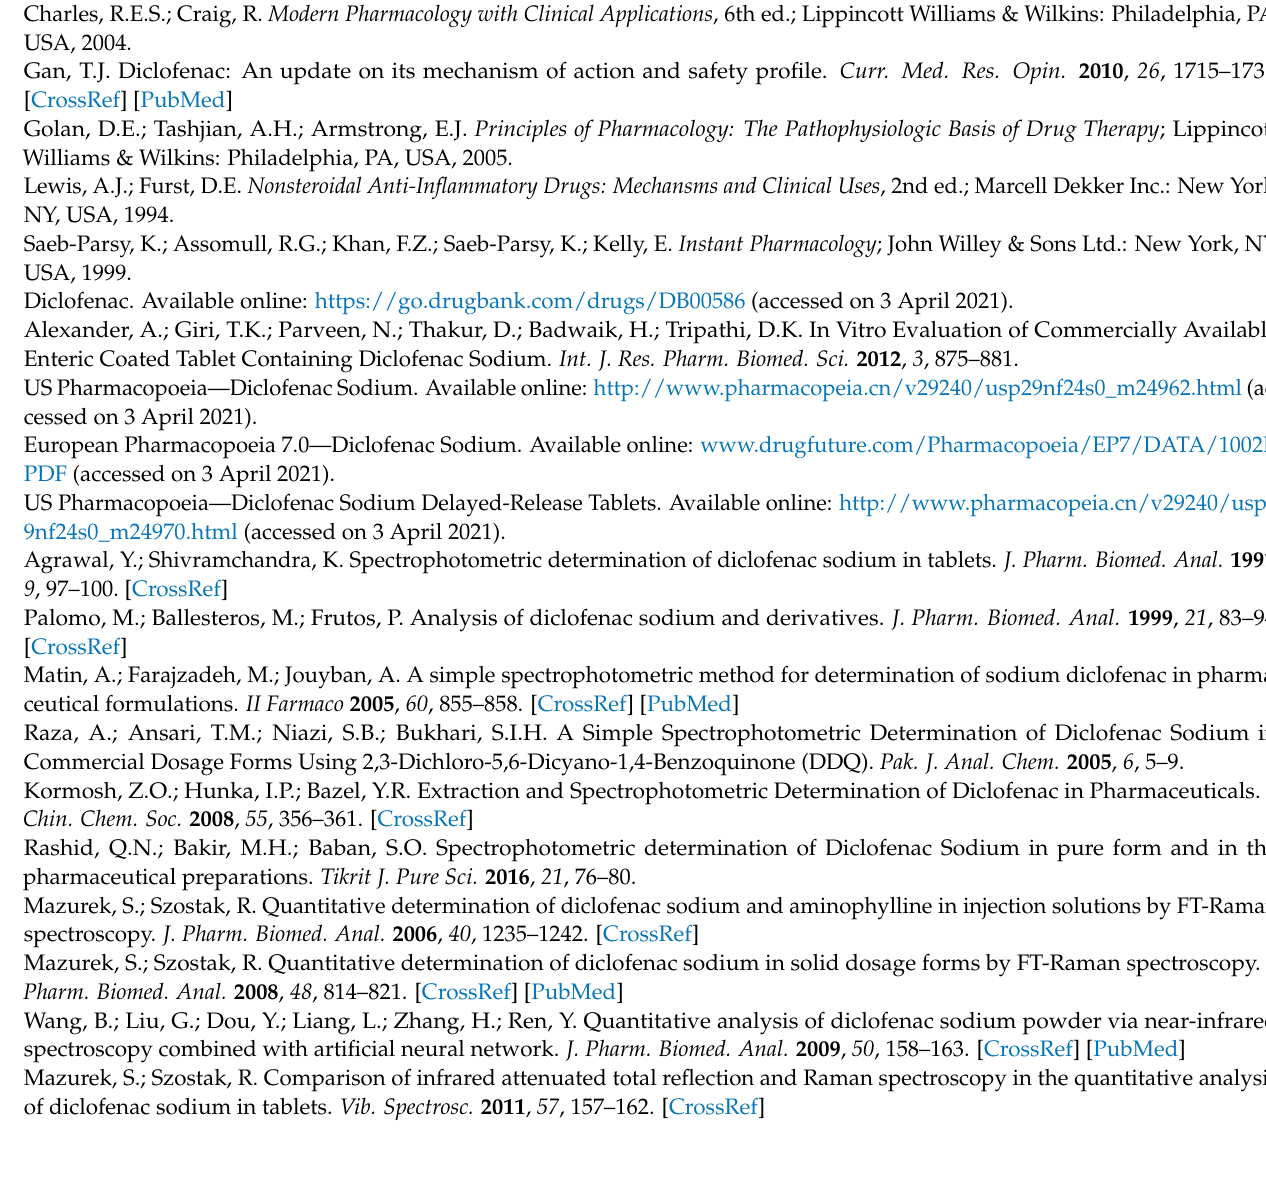
are included, Figure S3: FTIR spectrum of pure methanol as measured (blue) and with beaseline subtraction. A minor contribution of the solvent exists in the 1600–1500 cm − 1 region. Table S1: Predicted concentrations of the known samples’ solutions (test set), Table S2: ANOVA significance test and data summary, Table S3: UV calibration curve